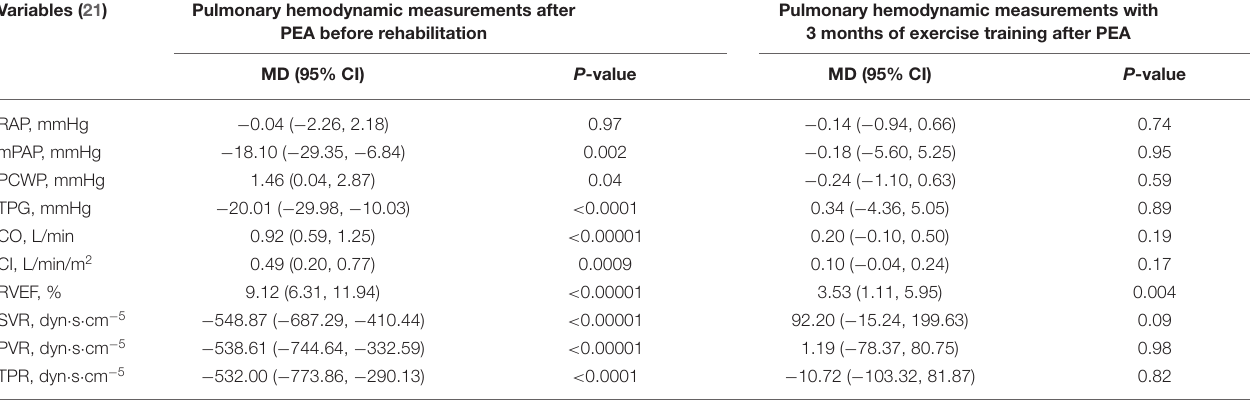
TABLE 3 | Forest plots of pulmonary hemodynamic measurements. Variables (21)